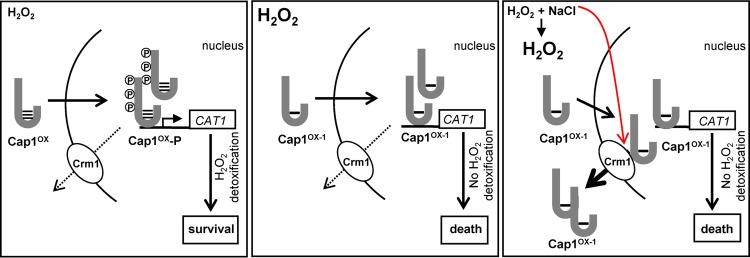
Impact of combinatorial stress and high H2O2 on Cap1 activation. When C. albicans cells are exposed to medium (5 mM) levels of H2O2, a Cap1OX form containing multiple disulfides is swiftly generated, followed by the rapid accumulation of Cap1 in the nucleus, where it is phosphorylated. The ensuing efficient induction of Cap1-dependent antioxidant genes follows, leading to stress adaptation and survival (left panel). However, when C. albicans cells are exposed to high (25 mM) levels of H2O2, a Cap1OX-1 form containing less disulfides is prevalent, and although this rapidly accumulates in the nucleus and binds to target genes, Cap1 is not phosphorylated, and the induction of Cap1-dependent genes is significantly impaired, resulting in cell death (middle panel). Exposure of C. albicans to medium (5 mM) levels of H2O2 in the presence of NaCl triggers high intracellular ROS accumulation. This also results in the formation of Cap1OX-1, which is seemingly unable to induce Cap1-dependent genes. However, following combinatorial stress, an additional inhibitory mechanism is seen as Cap1 fails to accumulate in the nucleus due to a cationic stress-mediated stabilization of the interaction between Cap1 and the Crm1 export factor. Consequently, the induction of Cap1 target genes is prevented, leading to cell death (right panel).